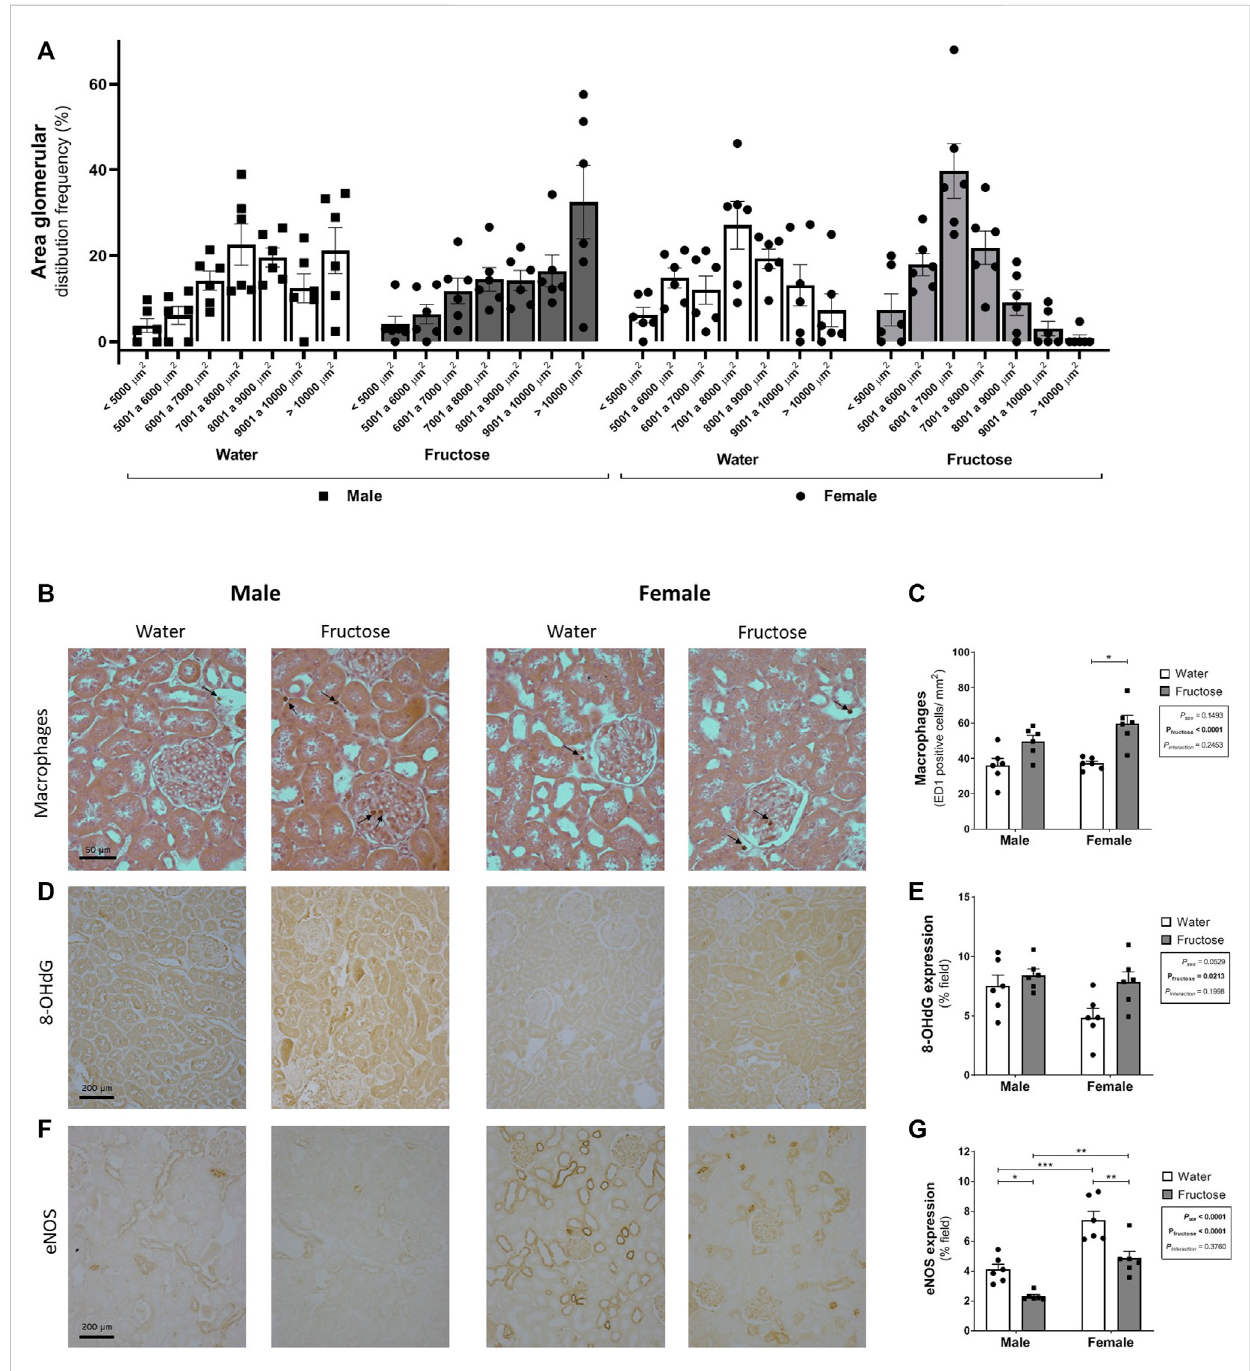
Glomerular area distribution according to the size (A) and expression of markers of renal dysfunction: representative photomicrographs and quantitative analysis by immunohistochemistry of the macrophages (B – C) (ED1 positive cells – arrows; original magni fi cation ×400);8-OHdG (D – E) ; and eNOS (F – G) (original magni fi cation ×200). Values are mean ± standard error. Two-way ANOVA followed by Tukey ’ s post hoc test, * p ≤ 0.05; ** p ≤ 0.01; **** p ≤ 0.001, six animals per